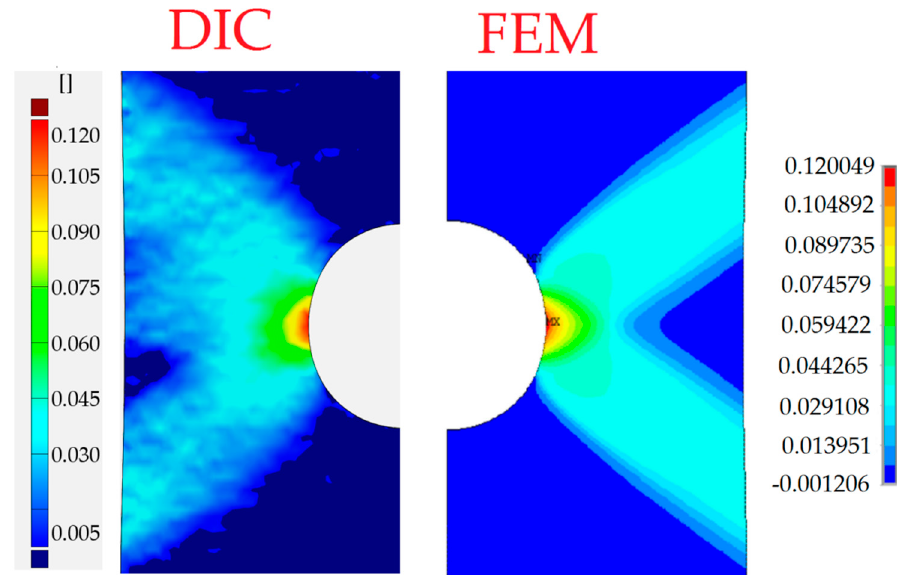
Figure 22. Comparison of total vertical strains distributions.